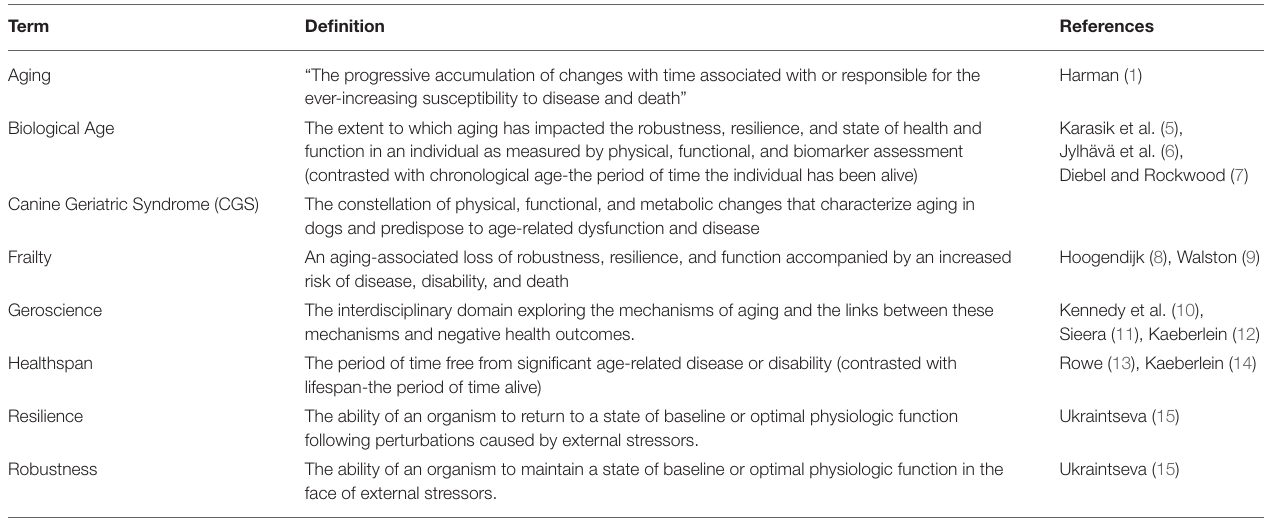
TABLE 1 | Glossary of key